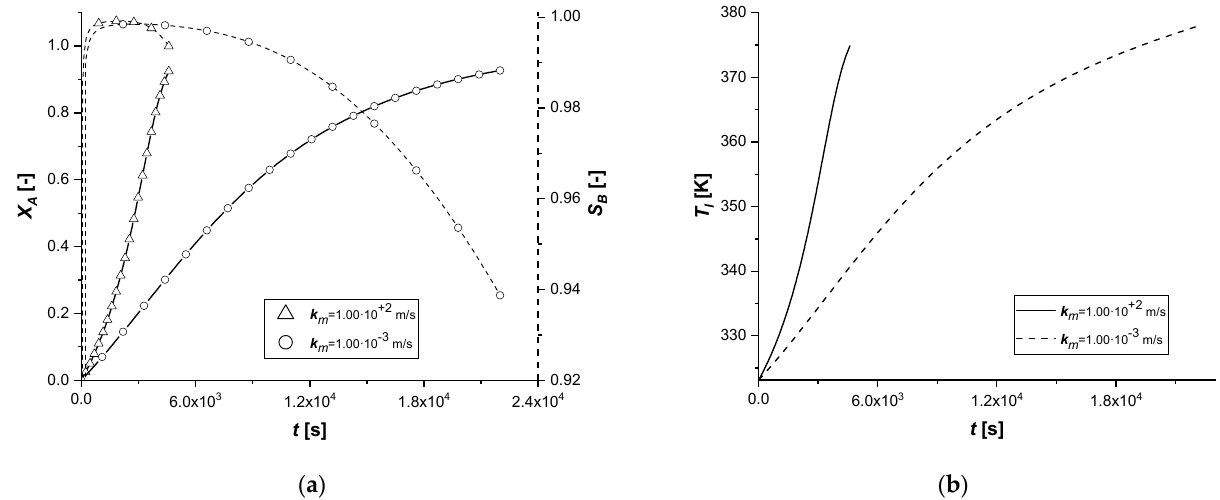
Figure 29. ES k m investigation. ( a ) Bulk profiles over time of X A and S B . ( b ) Bulk profile of T l over time.